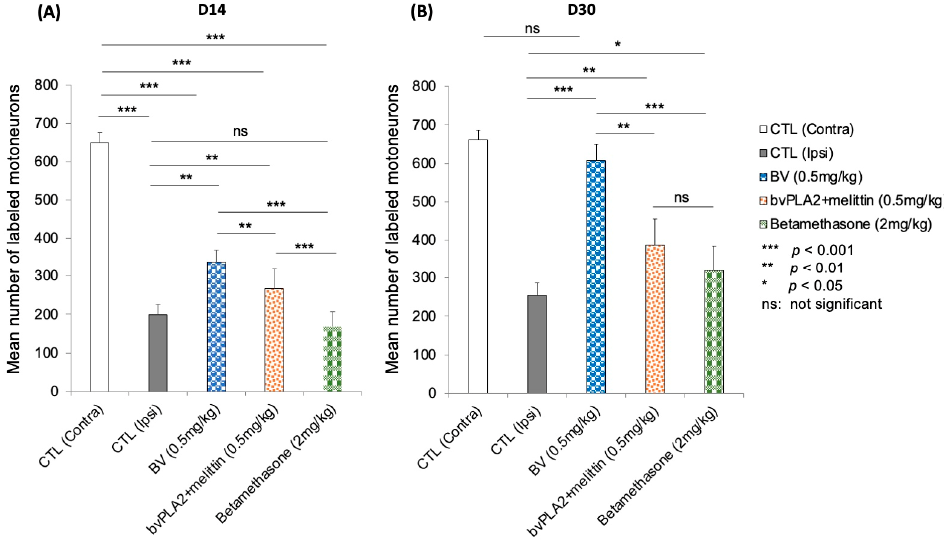
Figure 6. Quantitative analysis: Retrograde-labeled neurons were quantified 2 weeks after facial nerve injury. The data are presented as the means ± SD, and differences were tested by t -test. ( A ) On D14, the mean number of laterals labeled facial motoneurons was decreased, consistent with facial nerve section-suture. The number of neurons in the BV group was higher than that in the control and betamethasone groups (*** p < 0.001 and ** p < 0.01, respectively). ( B ) On D30, the number of labeled motoneurons returned to normal level in the BV-treated group (no statistical difference was observed compared to the contralateral side p > 0.05), which was not the case for the other experimental groups. At D30, the labeled facial motoneurons were increased in the BV-treated mice